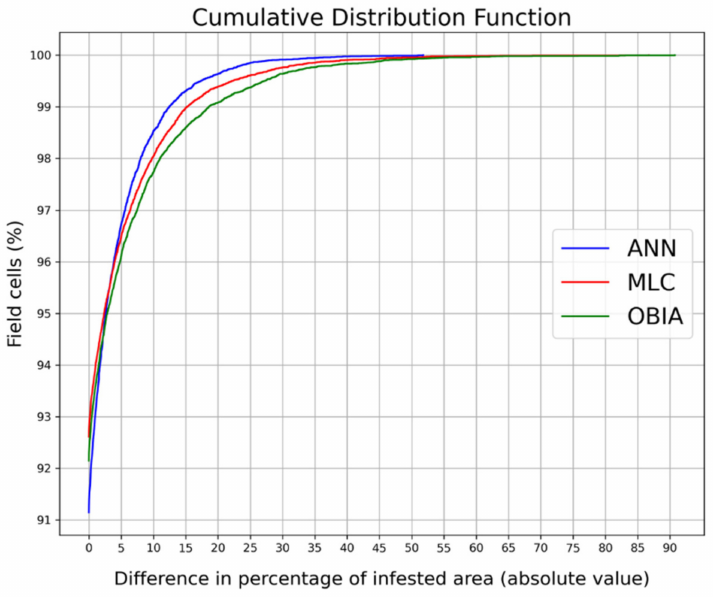
Figure 9. Cumulative distribution of the field treatment cells vs. the difference in percentage of infested area in absolute